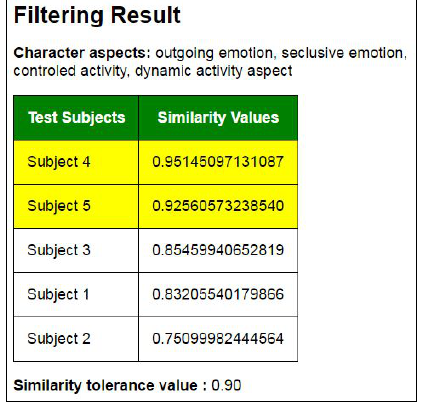
Fig. 7. Filtering result of outgoing emotion, seclusive emotion, controlled activity, and